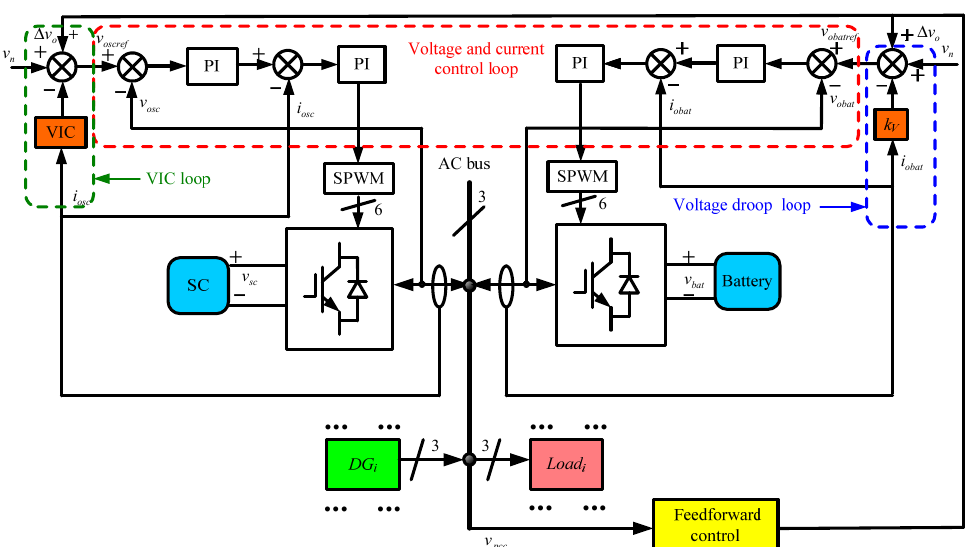
Figure 6. General control diagram of HESS converters with VIC and voltage droop control strategy.